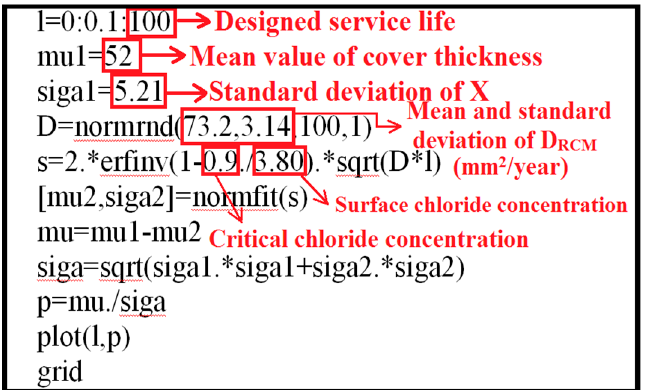
Figure 13. Programming language of Monte-Carlo simulation.